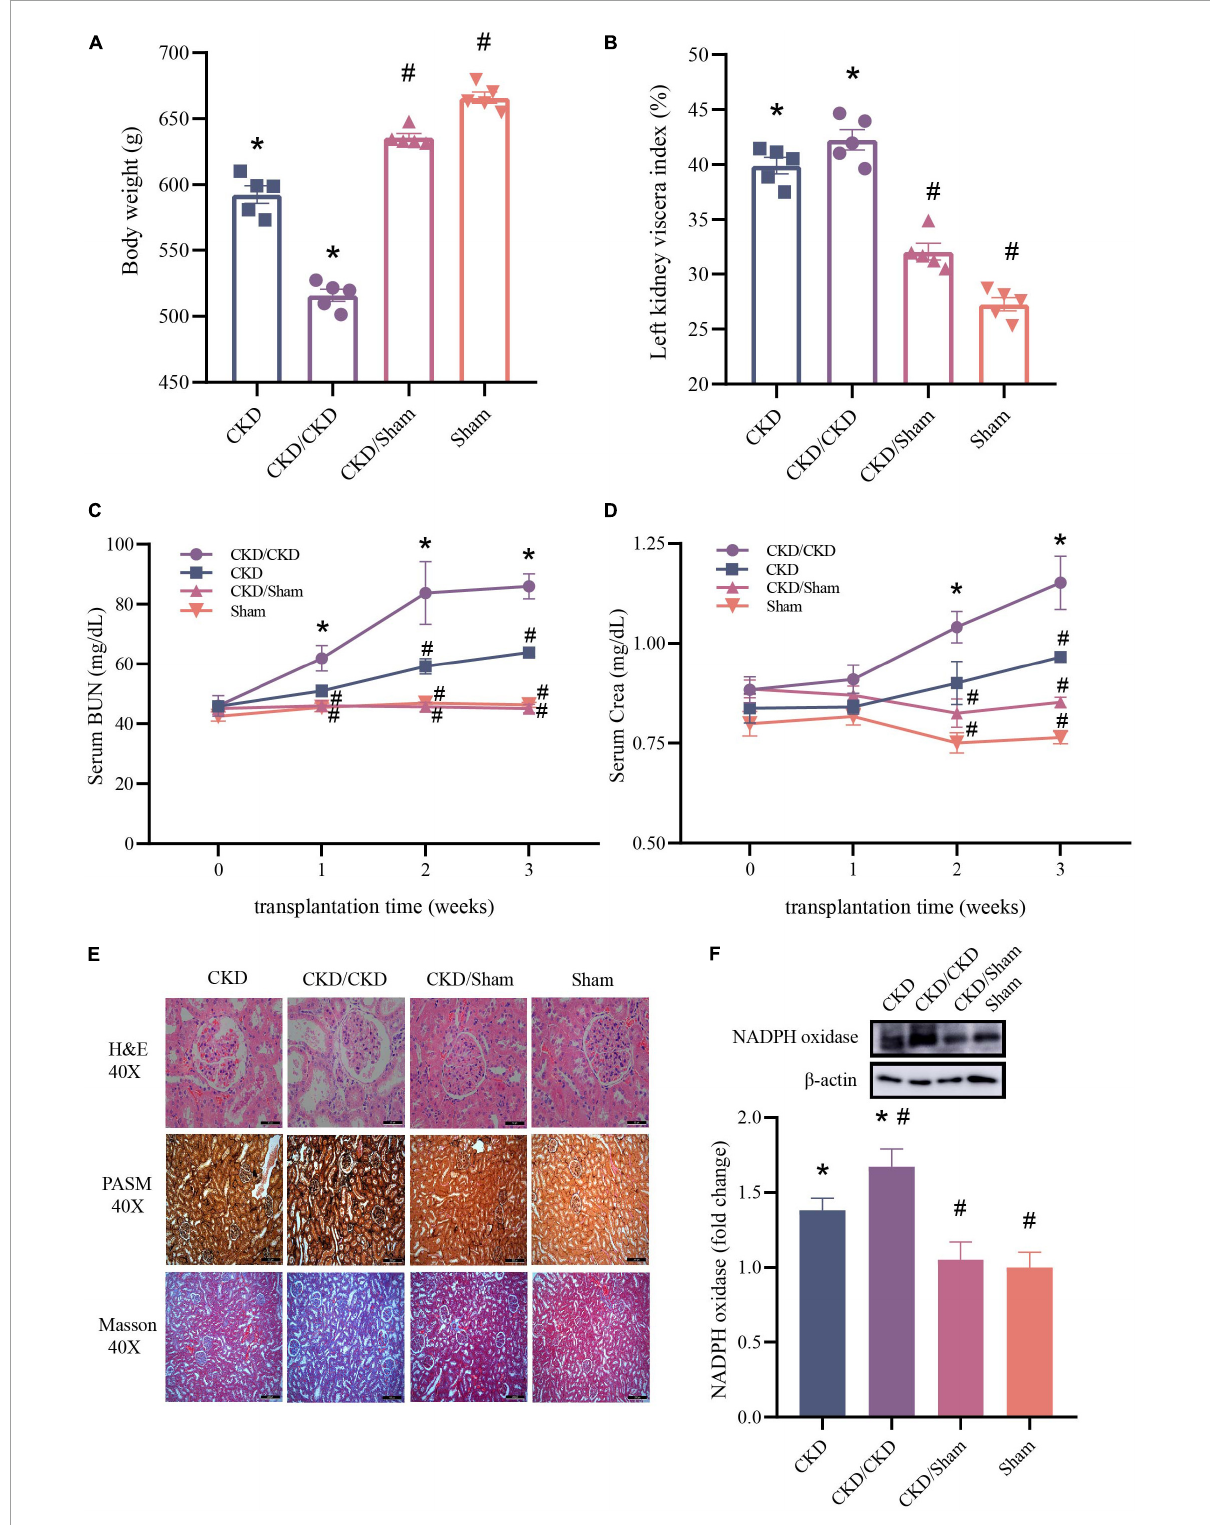
FIGURE9 Changes of renal function related indicators after successful FMT. (A) Body weight. (B) Left kidney viscera index. (C) BUN. (D) Crea. (E) Histology of kidney tissue stained with H&E, PASM, and Masson. (F) Western blot results for NADPH oxidase. The data is presented as means ± SEM. n = 5. *VS Sham group P < 0.05, # VS group CKD P <